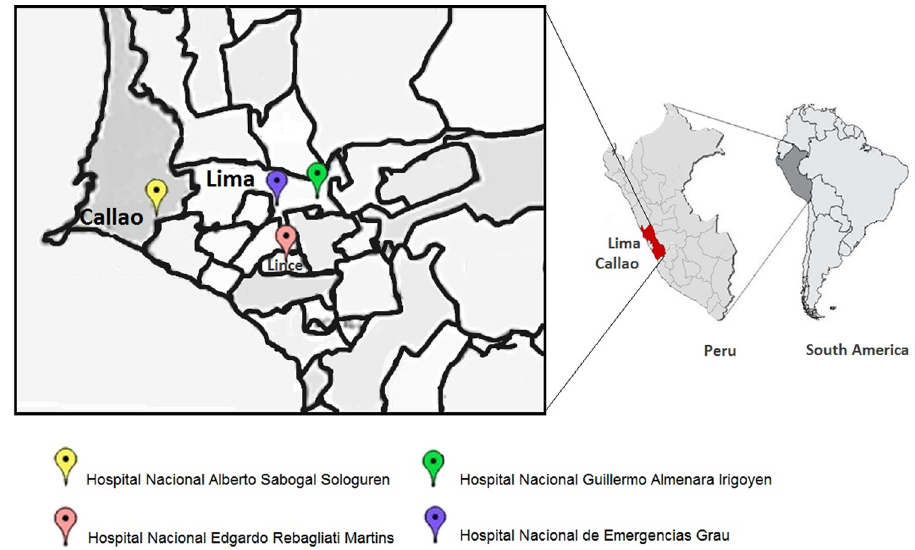
Figure 1. Location of the four EsSalud hospitals included in the study. Hospital Nacional Guillermo Almenara Irigoyen,HospitalNacionalEdgardoRebagliatiMartins,andHospitalNacionaldeEmergenciasGrauinLima,andthe Hospital Nacional Alberto Sabogal Sologuren in Callao province. Maps by ©Jeel